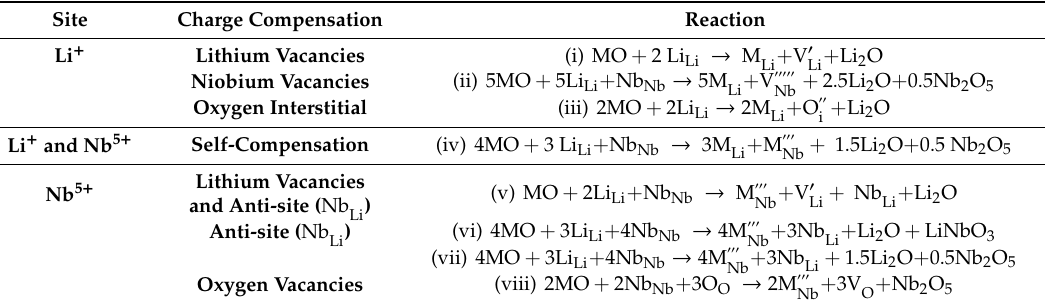
Table 3. Types of defects considered due to M = V 2+ incorporation in LiNbO 3.